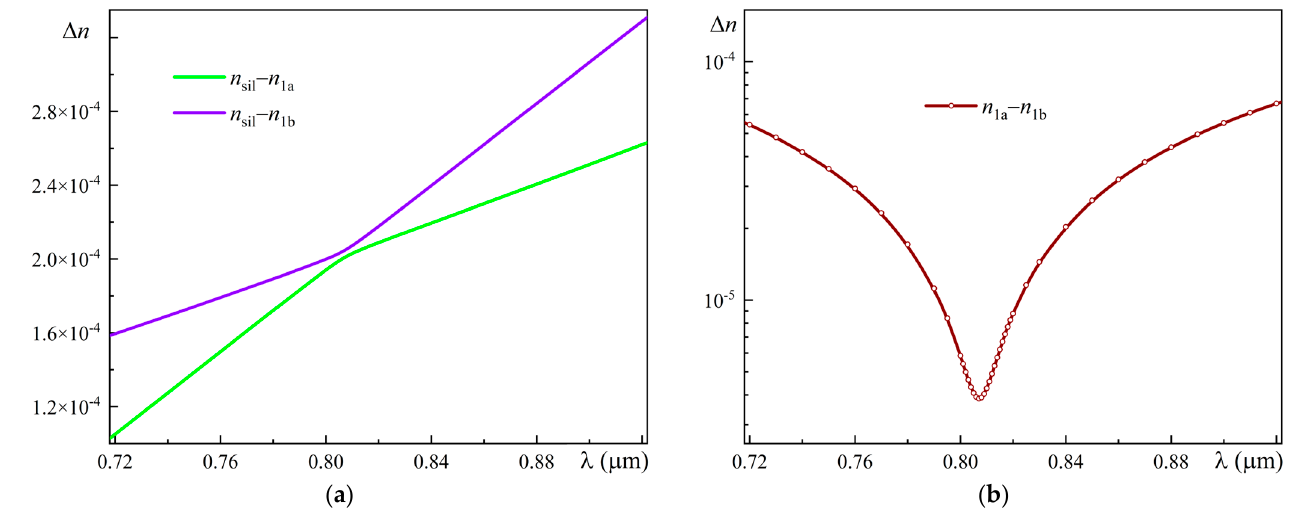
Figure 10. Spectral dependences for a bent MOF-18 with a bending radius of R x = 0.08 m: ( a ) of the difference between the refractive indices of pure silica glass and the effective refractive indices of Modes 1a and 1b: n sil – n 1a and n sil – n 1b ; ( b ) of the difference n 1a – n 1b between the effective refractive indices of Modes 1a and 1b.